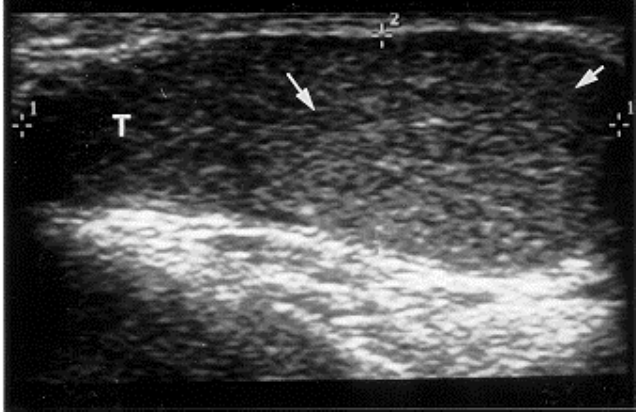
FIGURE 1A. Longitudinal ultrasonogram demonstrates the splenic mass (arrows) which is slightly hypoechoic positioned above the normal appearing testis (T).